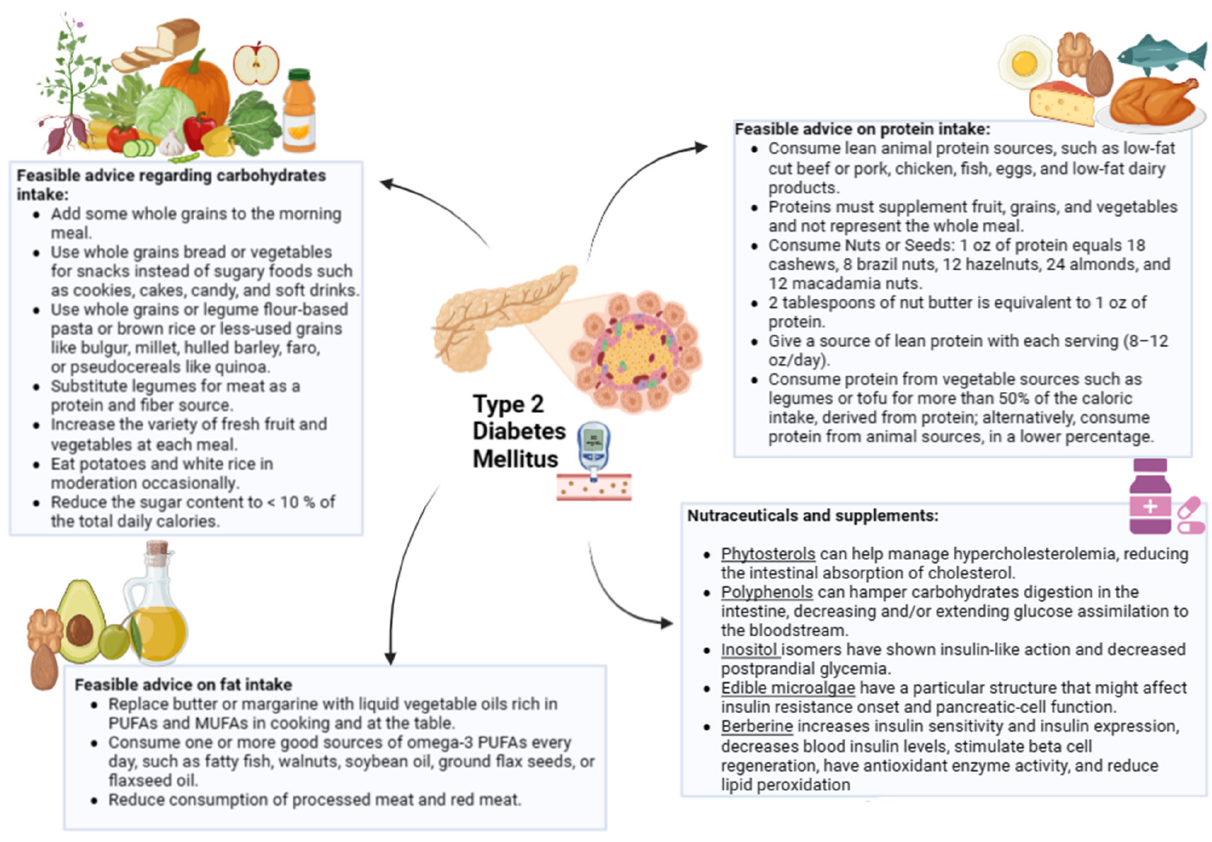
Figure 1. Graphic representation of dietary and integrative treatment for patients with type 2